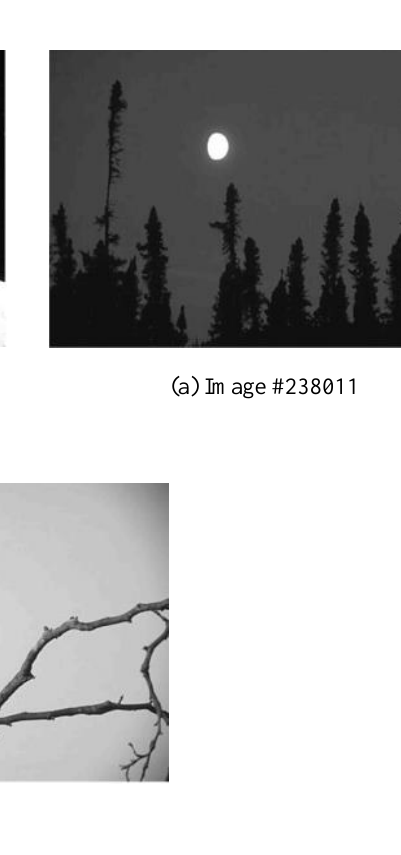
Figure 9. The selected test images from Berkeley database.